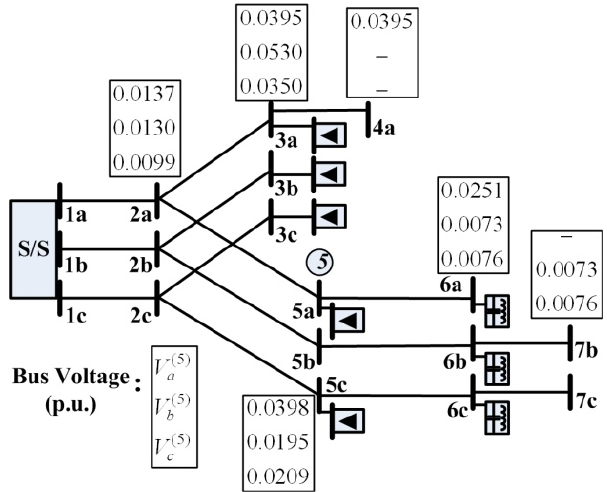
Figure 5. Bus voltage of the 5 th -order harmonic